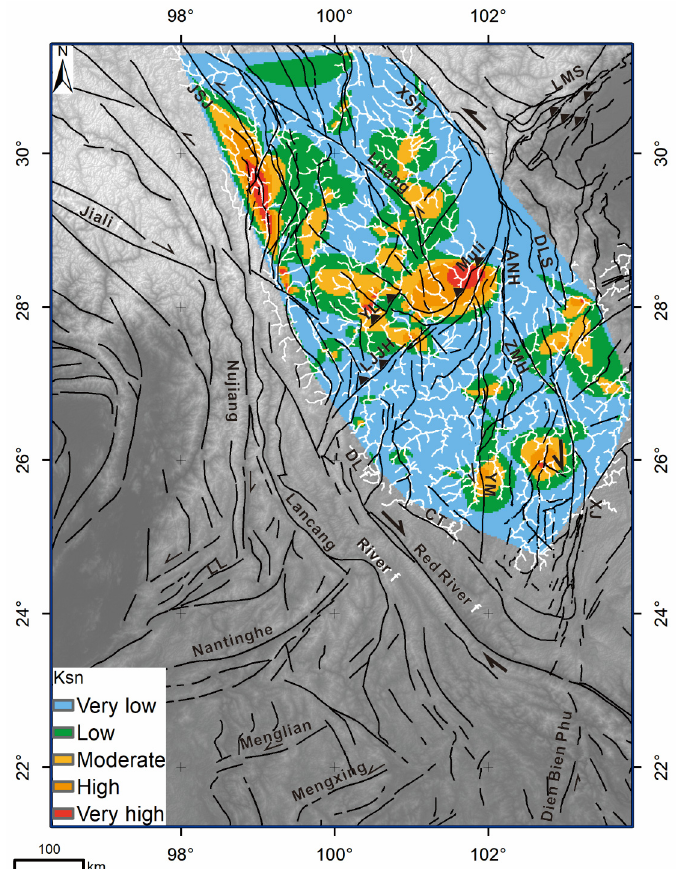
Figure 4. Map of channel steepness indexes that are normalized (K sn ) to a reference concavity ( θ ref ) of 0.45. Note that we only selected streams of the same order for comparison throughout the Yangtze river drainage, calculated using the stream profiler tool (www.geomorphtools.org, accessed on 3 April 2021) with a smoothing window of 1000 m. The colors represent the following values: Blue—very low (2–631), green—low (631–1361), yellow—moderate (1361–2463), orange—high (2463–4301), and red—very high (>4301).